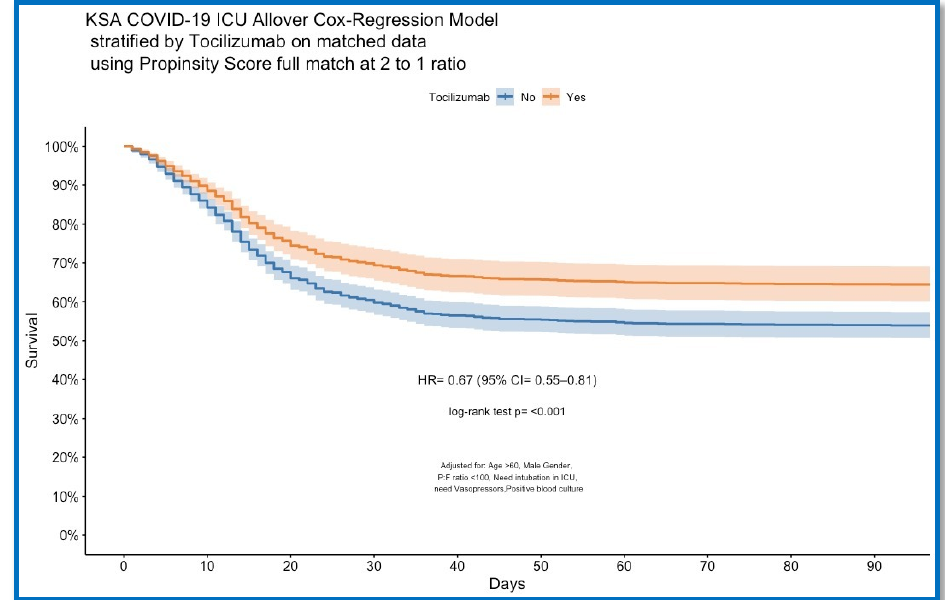
Figure 2. COVID-19 ICU Cox regression model of overall 28 day survival stratified by tocilizumab on propensity-matched data with a 2:1 ratio.